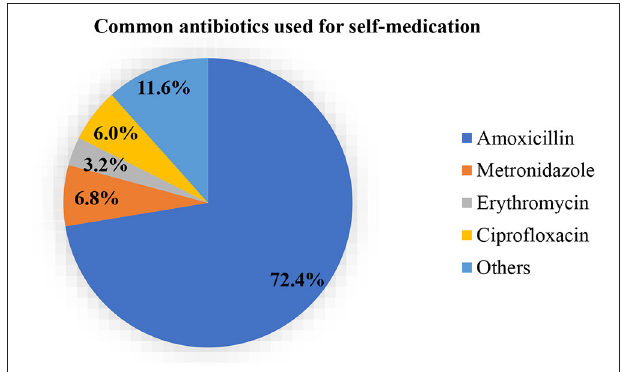
FIGURE 1 | Proportions of common antibiotics used for